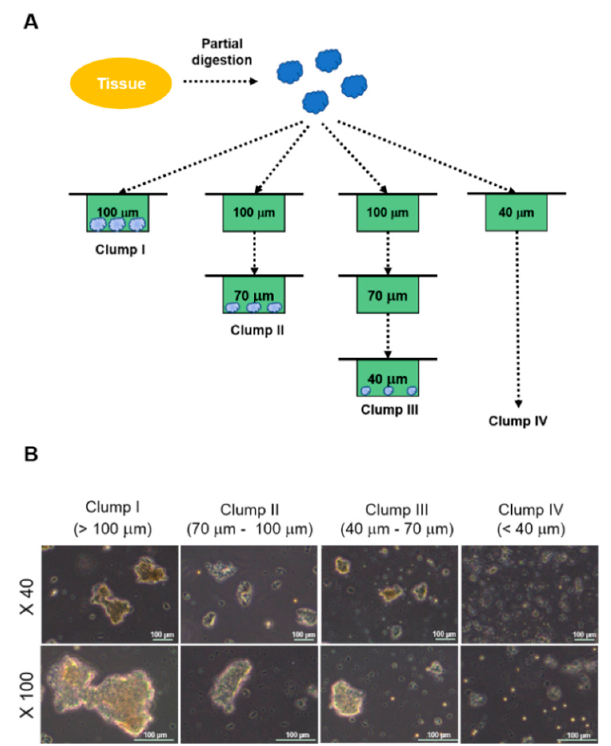
Figure 1. Experimental design and morphologies of clumps. ( A ) Experimental design to retrieve four types of clumps is illustrated. ( B ) Morphologies of four clump types is presented. Scale bar = 100 µm.